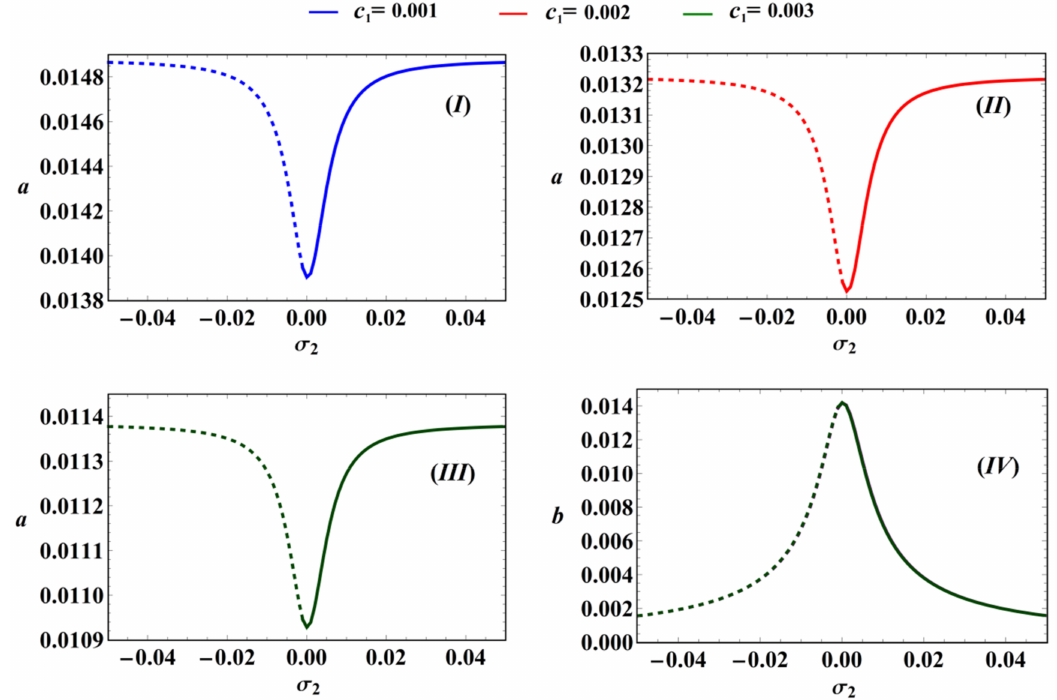
Figure 12. The frequency response at σ 1 = − 0.001, W = 0.448, and c 2 = 0.011 of: a ( σ 2 ) when ( I ) c 1 = 0.001, ( II ) c 1 = 0.002, ( III ) c 1 = 0.003, and ( IV ) for b ( σ 2 )